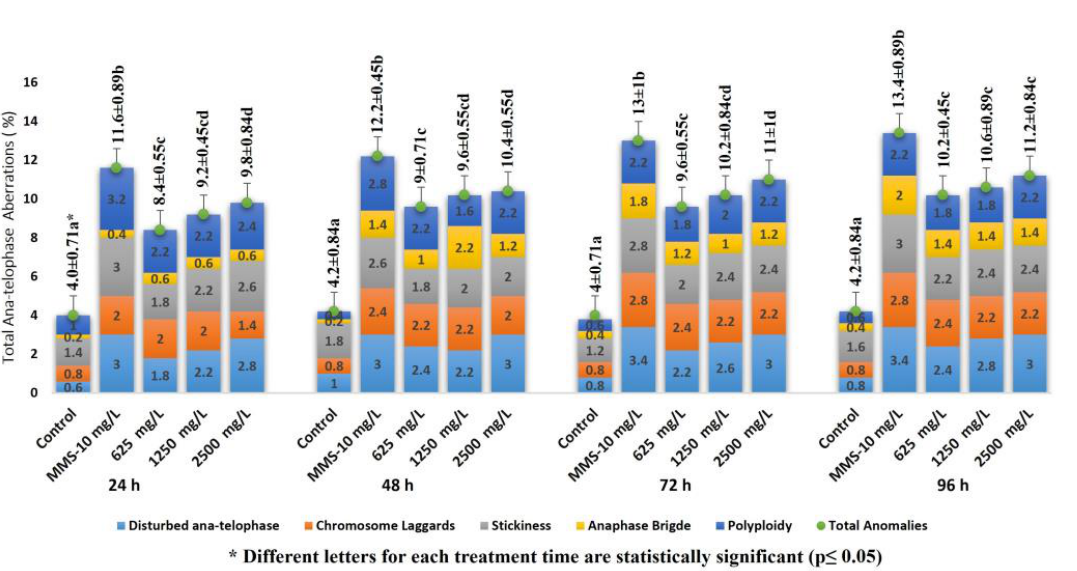
Figure 3. Typical stages of mitosis ( a – d ) and ana-telophase anomalies ( e – i ) induced by FLB in A. cepa cells. Scale bars: 10 µm. The results from the comet assay are summarized in Figure 4. The MI results and CAs correlate well with that of the comet assay. As can be seen, exposure to FLB in- creased the DNA damage rate at all concentrations in a dose- and time-dependent man- ner. The comet assay results showed significantly higher DNA damage values at all of the FLB concentrations compared to those of the negative control (F = 1265.8 df = 4 p = 0.00 for 24 h; F = 2836.5, df = 4, p = 0.00 for 48 h; F = 1720, df = 4, p = 0.00 for 72 h; F = 2059.5, df = 4, p = 0.00 for 96 h).